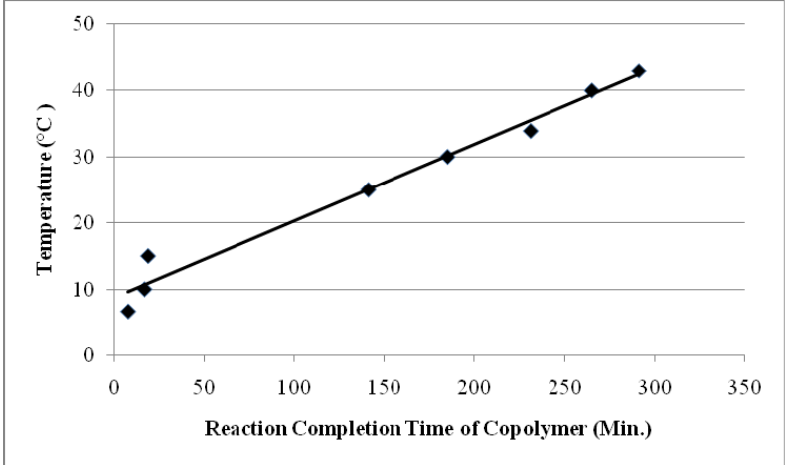
Figure 21. Temperature vs. Reaction Completion Time of Copolymer with dopant.